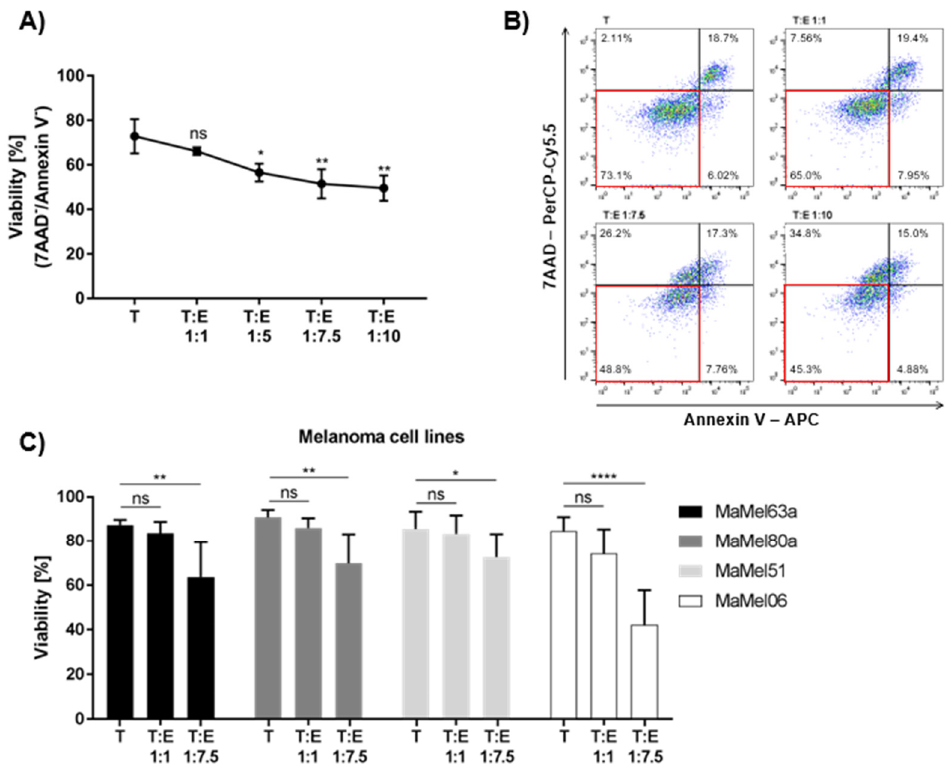
Figure 3. Eosinophils exert tumoricidal function towards various melanoma cell lines to different extents. Non-adherent (co-)cultures of melanoma cell lines (T) with or without eosinophils (E) for 24 h. ( A ) Eosinophils show a significant target to eosinophil ratio-dependent cytotoxic effect towards MaMel63a cells. A ratio of 1:5 melanoma cells to eosinophils is sufficient to significantly decrease MaMel63a cell viability. Mean percentage of MaMel63a cell viability is shown for three independent experiments. ( B ) Representative viability gating strategy for 7-AAD / Annexin-V staining of 24 h co-cultures of MaMel63a cells with eosinophils. Viable cells displayed in red box. ( C ) Cytotoxicity assessed in different melanoma cell lines, MaMel63a, MaMel80a, MaMel51 and MaMel06. Mean percentage of melanoma cell viability ± standard deviation (SD) is shown for six to eight independent experiments. ns p > 0.05, * p < 0.05, ** p < 0.01, **** p <